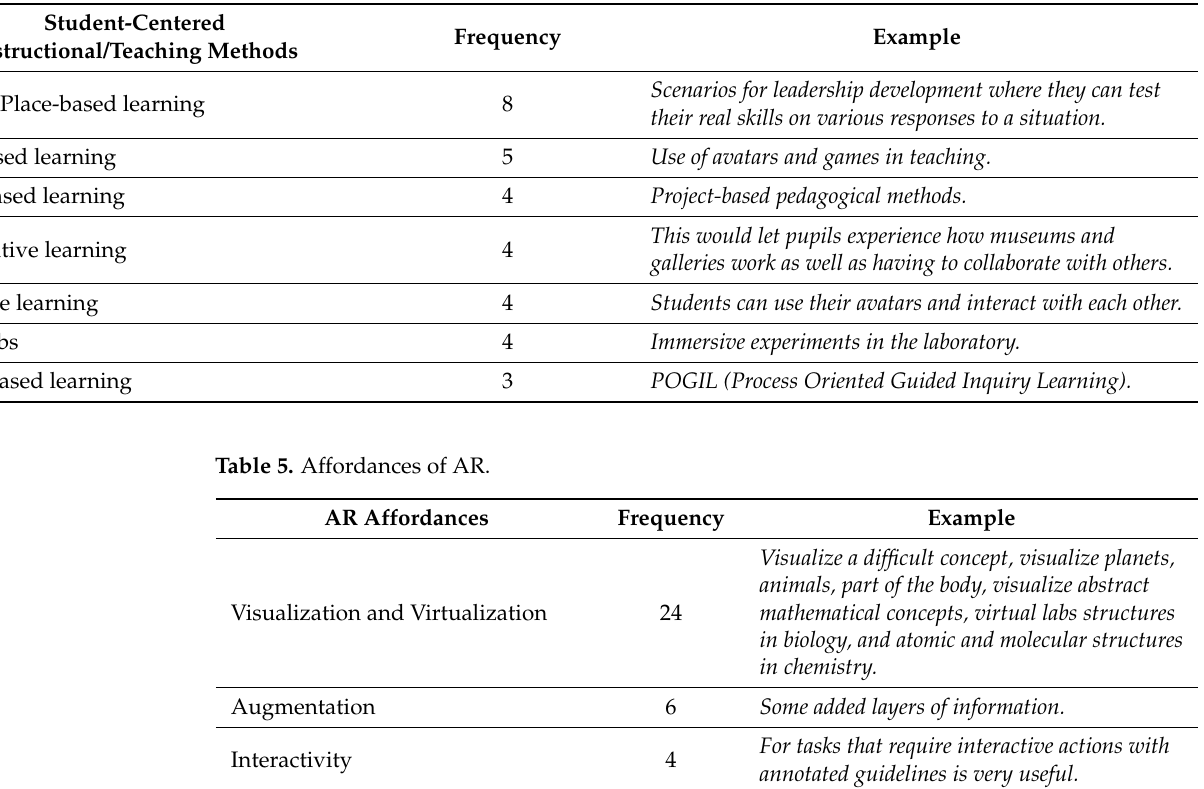
Table 4. Student-centered instructional/teaching methods for integrating ARinE.